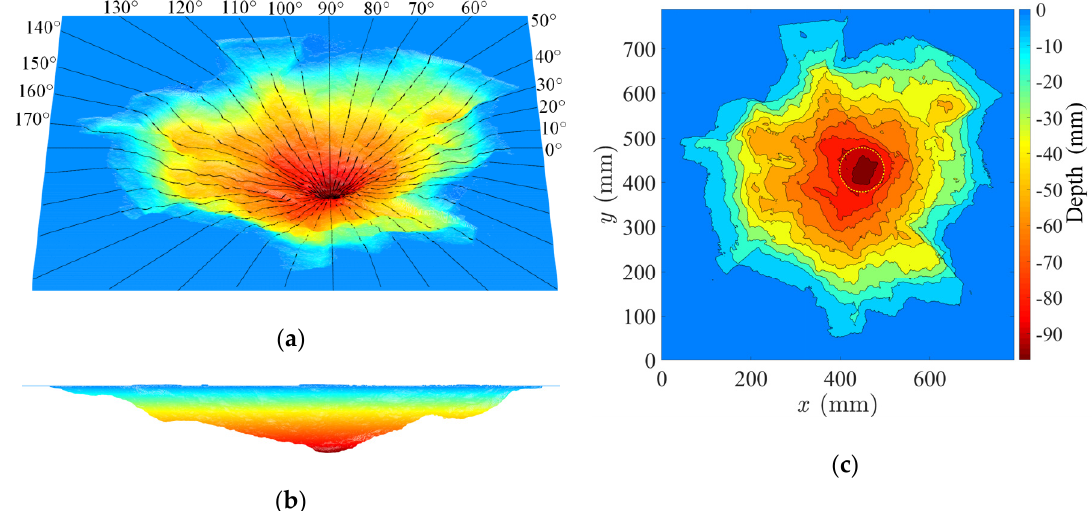
Figure 7. Three-dimensional (3D) digital elevation model of impact crater (Shot No. 10): ( a ) oblique view; ( b ) lateral view; ( c ) top view with depth contour lines.